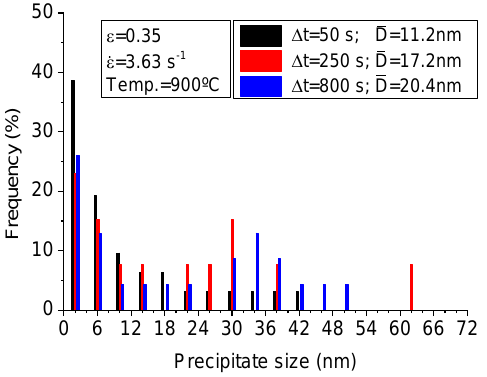
Figure 7. Size distribution of precipitates for specimen tested at reheating temperature of 1200 °C for 10 min, deformation temperature of 900 °C, and holding times of 50 s, 250 s, and 800 s.